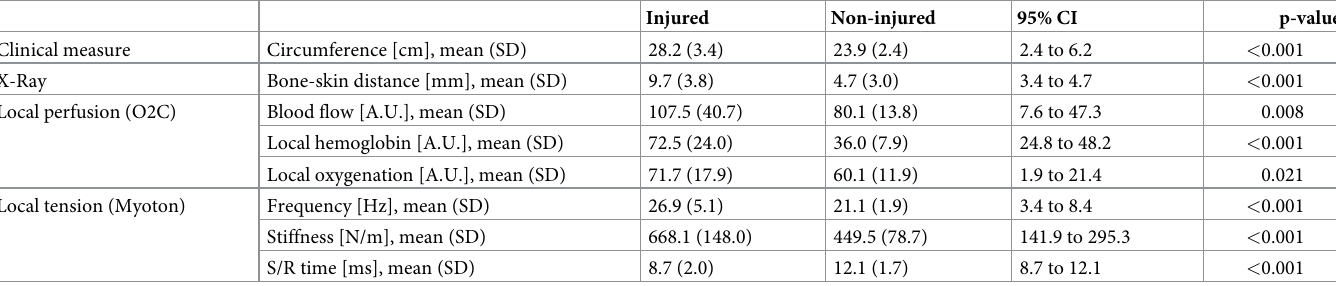
Table 2. Quantification of physical soft tissue properties at admission.